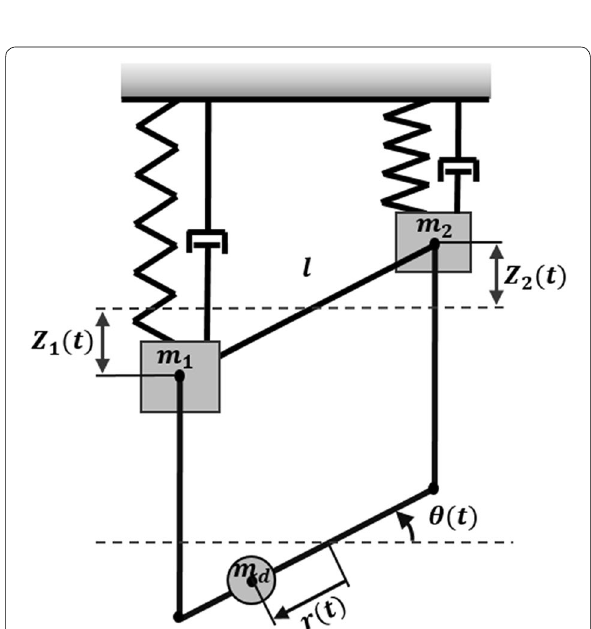
Fig. 4 Floaters attached to a spring and a damper. A set of mass-spring-damper system is replaced with the environmental active